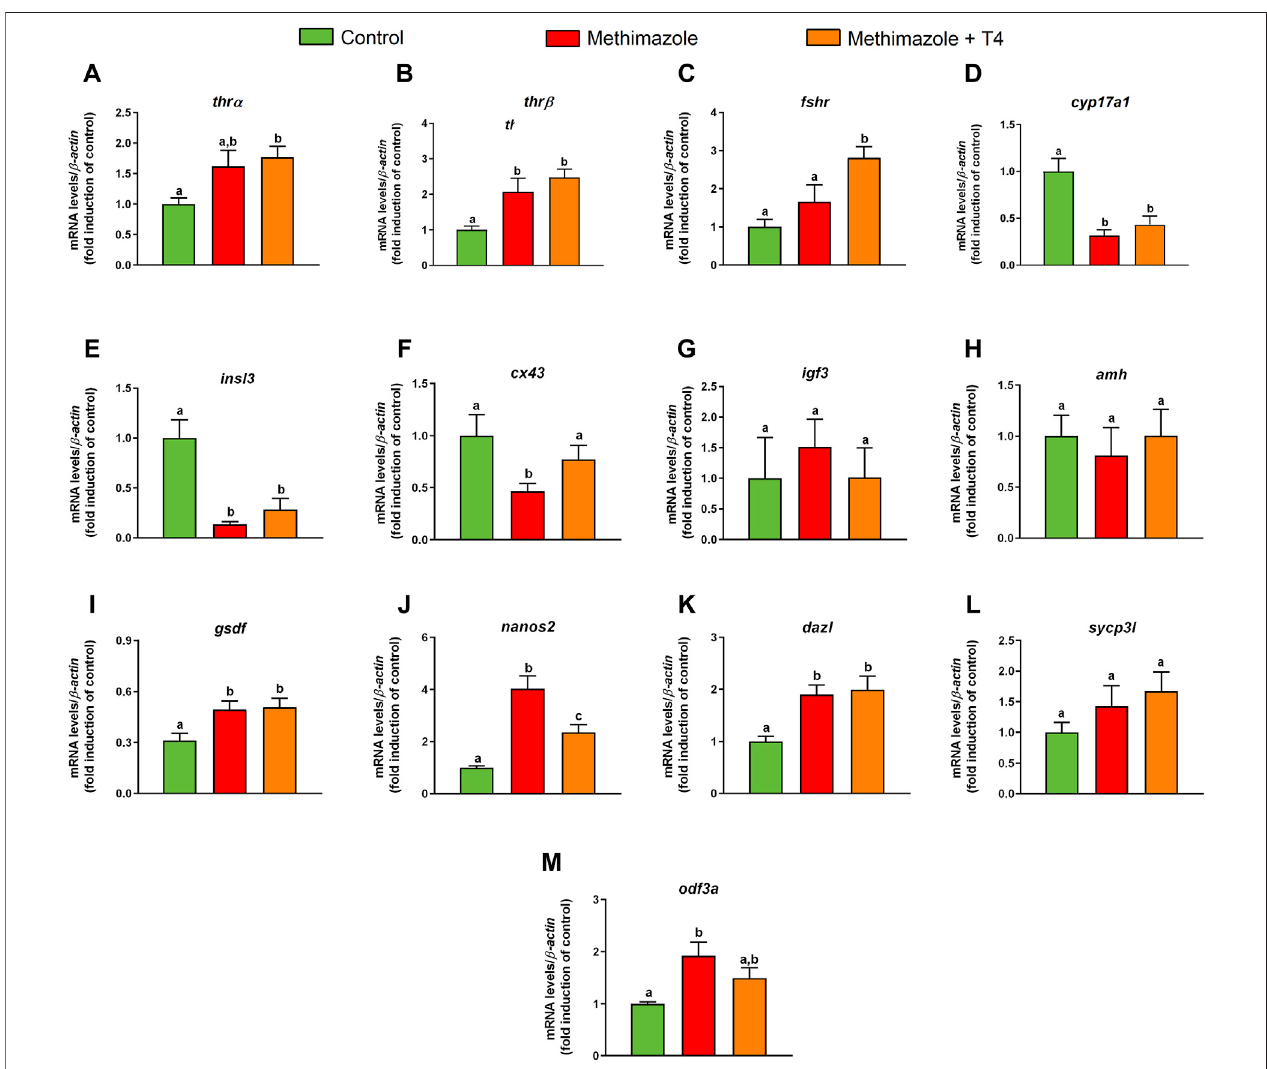
FIGURE 3 | Relative mRNA levels of selected genes expressed in zebra fi sh testis after in vivo exposure to methimazole and methimazole co-treated with T4 for 3 weeks. The selected genes thr α and thr β (thyroid hormones receptor) (A,B) ; fshr (follicle-stimulating hormone receptor) (C) ; genes expressed by somatic cells (Leydig and Sertoli cells) (D – I) ; cyp17a1 (17 α -hydroxylase/17,20 lyase) (D) ; insl3 (insulin-like peptide 3) (E) ; cx43 (testicular connexin) (F) ; igf3 (insulin-like growth factor 3) (G) ; amh (anti-Müllerian hormone) (H) ; gsdf (gonadal somatic cell derived factor) (I) ; and germ cell markers (J – M) ; nanos2 (J) ; dazl (deleted-in azoospermia-like) (K) ; sycp3l (synaptonemal complex protein 3) (L) ; odf3a (outer dense fi ber of sperm tails 3B) (M) were evaluated. Ct values were normalized with β -actin and expressed as relativevaluesofcontrollevelsofexpression.Barsrepresentthemean±SEMfoldchange( n =8)relativetothecontrol,whichissetat1.Studentunpaired t -test.Different letters denote signi fi cant differences ( p < 0.05) between different treatment conditions with the control.